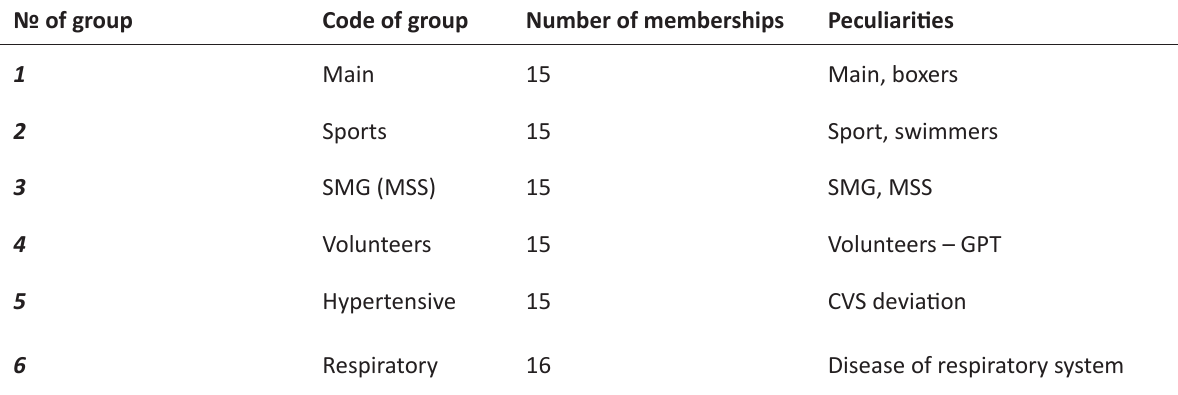
Table 1. Participants and groups of physical training № of group